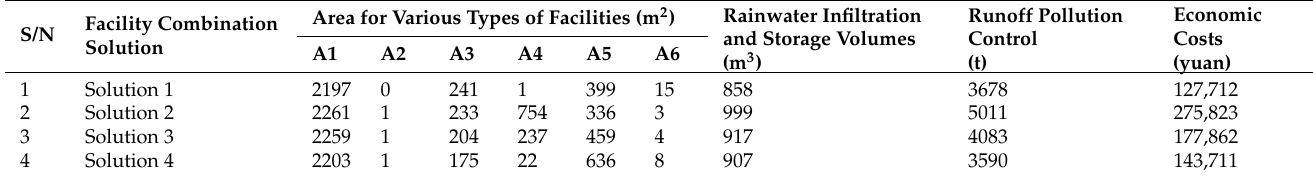
Table 10. A comprehensive optimal solution based on the NSGA-II